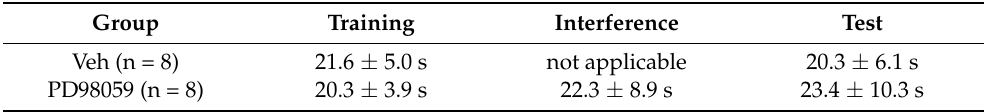
Table 3. Exploration time during training, interference, and test, relative to Figure 3. Veh: vehicle; PD98059: MEK